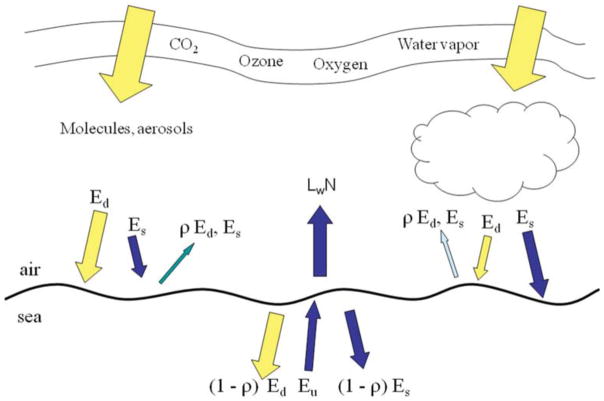
irradiance pathways in OASIMEd is direct downwelling irradiance, Es is diffuse downwelling. ρ surface reflectance, Eu is diffuse upwelling irradiance, and LwN is normalized water-leaving radiance. All irradiances and radiances are spectrally resolved at 25 nm for Ed, Es, and Eu. and 1 nm for LwN.